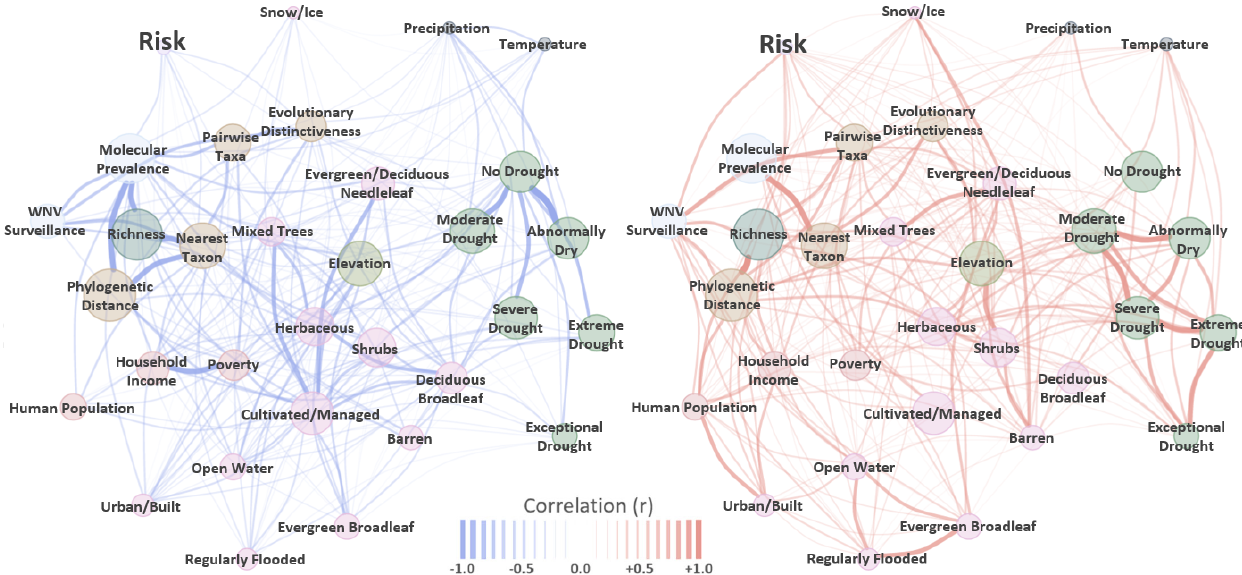
Figure 1. Network—correlation correlation graph. Networks display negative ( left ) and positive ( right ) correlations among evaluated input covariates and model estimated risk (larger text, upper left in each graph). Network nodes are labeled to indicate model covariate name and are sized to reflect the absolute magnitude of average Pearson linear correlation (r). Graph edges (lines) are color coded to indicate polarity (blue = negative, red = positive) with widths sized according to legend at bottom to signify absolute magnitude of pairwise correlation (range = − 1 to + 1). Graph structure among node positions (groups, clusters, or nestedness) approximate average connectivity (“node